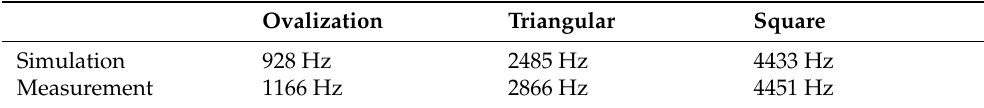
Table 6. Machine’s normal modes frequencies comparison. Ovalization Triangular Square